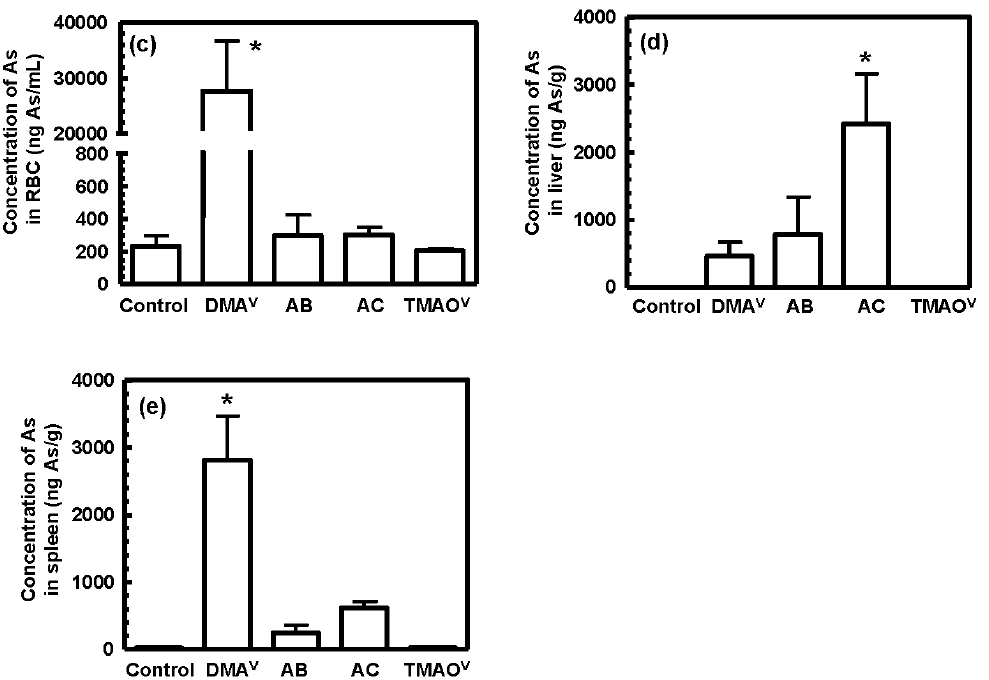
Figure 1. Concentrations of arsenic in ( a ) whole blood; ( b ) plasma; ( c ) RBCs; ( d ) liver and ( e ) spleen after oral administration of deionized-distilled water (control), DMA V , AB, AC or TMAO V . Values are presented as the means ± SD ( n = 4). Asterisks indicate significant differences ( p < 0.05) compared to the control value.